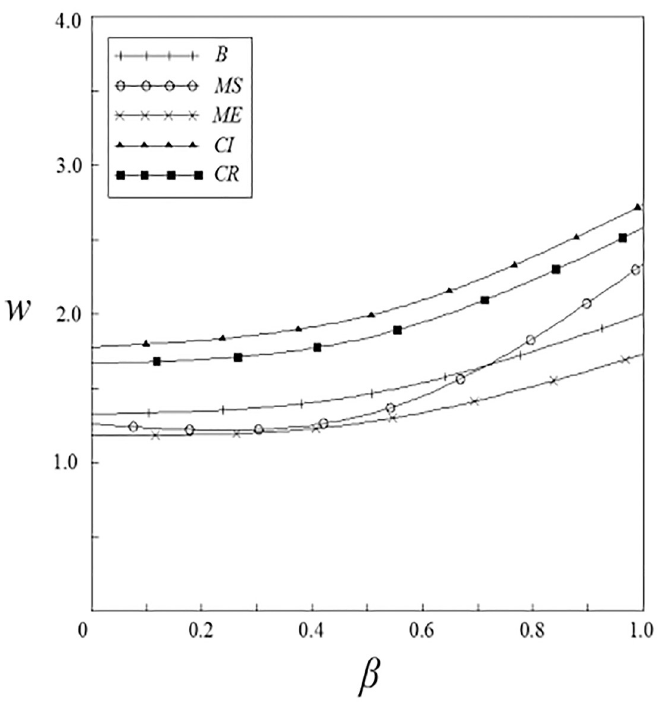
Fig 8. The relationship between w and β